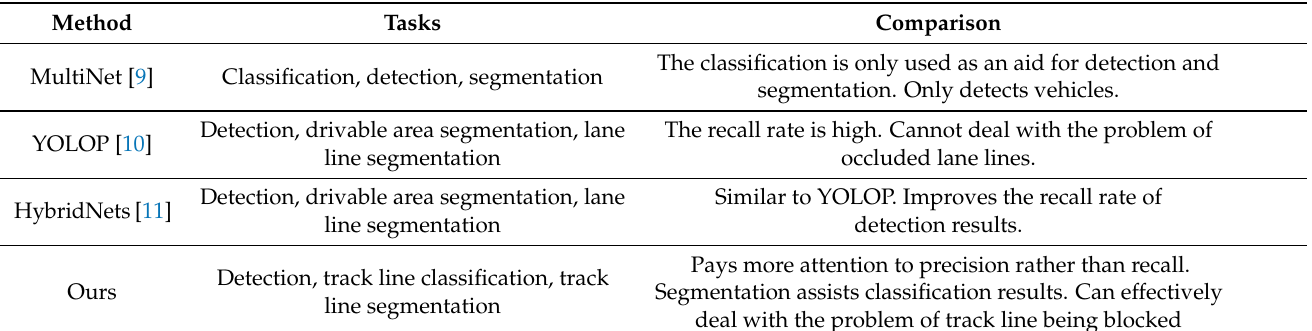
Table 1. The comparison of multitask methods in driving